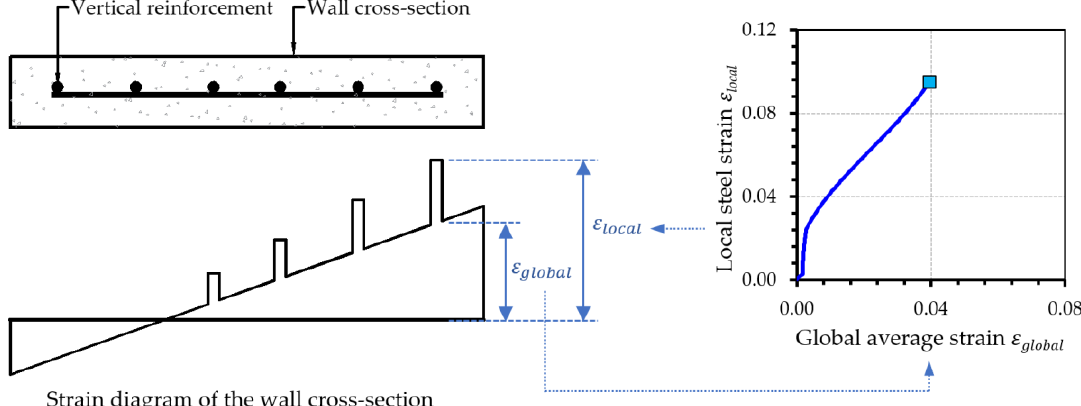
Figure 9. Illustration of the tension stiffening model proposed by Menegon et al. [55] (the figure is adapted from Menegon [39]).